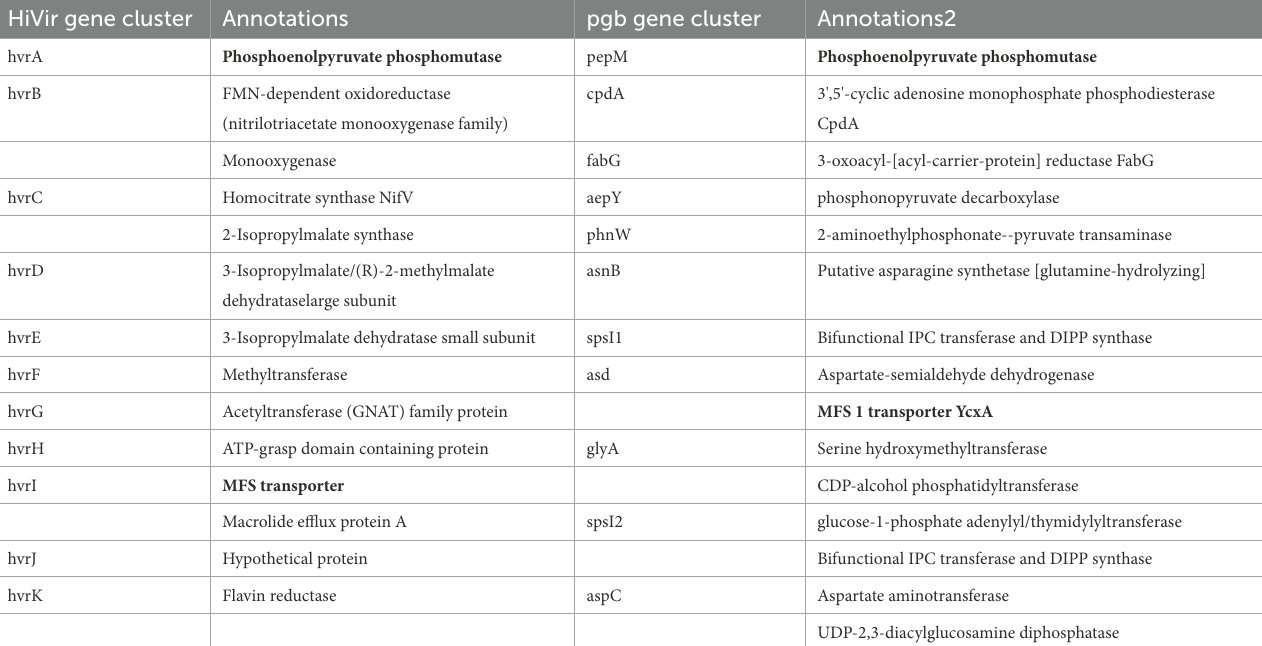
TABLE 4 Composition and annotation of the HiVir and the pgb gene clusters in Pantoea ananatis . HiVir gene